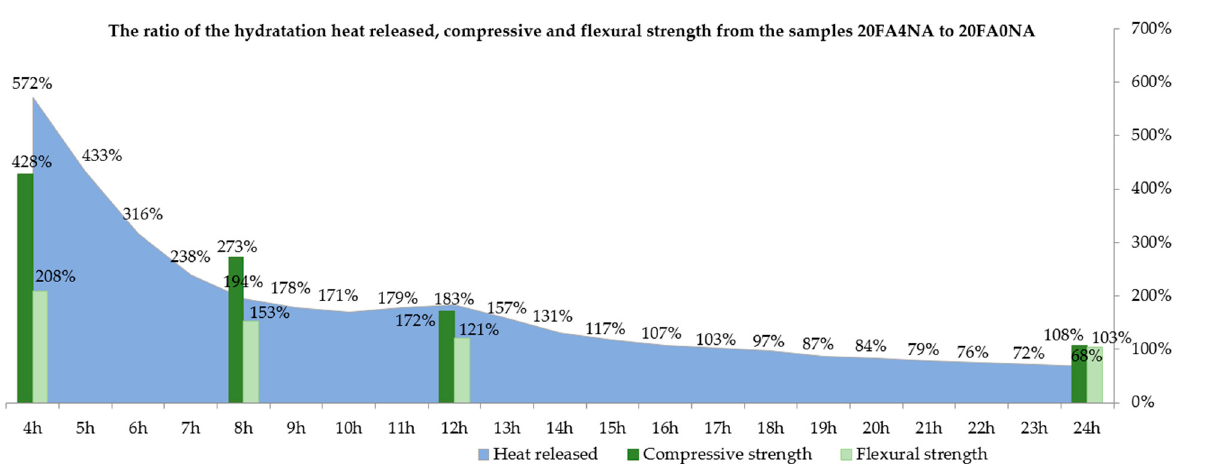
released hydration heat was atypical. In the NA modified samples, there was a rapid